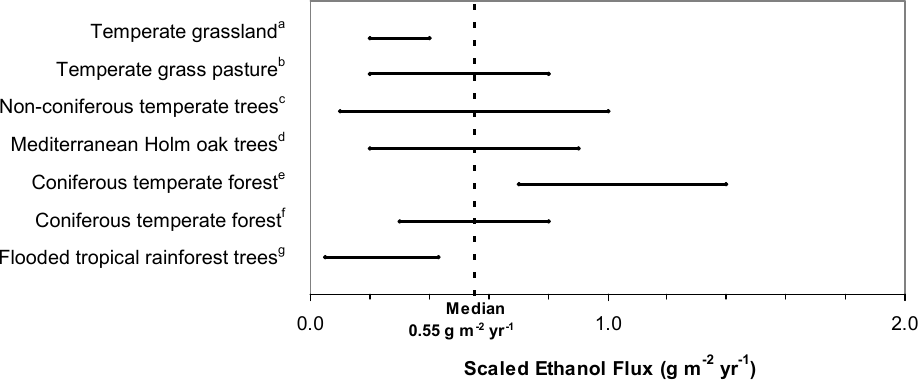
Fig. 1. Scaled annual estimates of ethanol emissions from plants based on the ethanol emission fluxes available in the literature. References are a Fukui and Doskey (1998), b Kirstine et al. (1998), c Helmig et al. (1999), d Holzinger et al. (2000), e Schade and Goldstein (2001), f Grabmer et al. (2006), g Rottenberger et al.